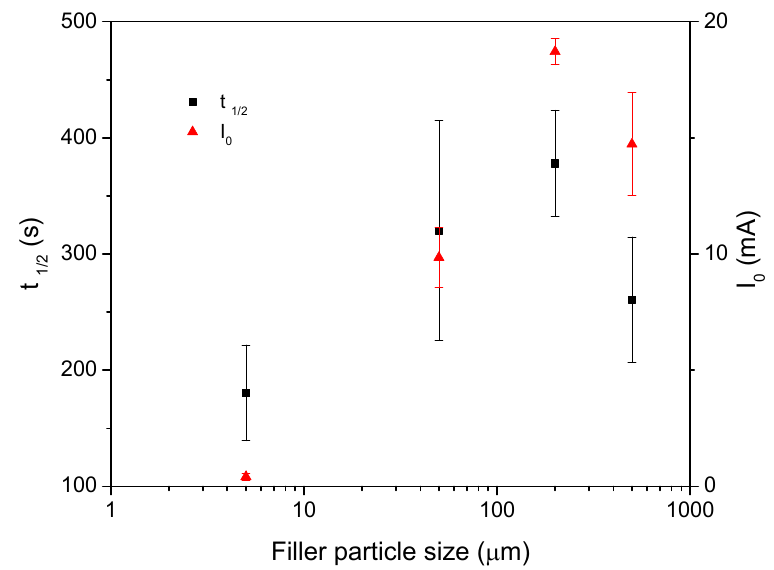
Figure 5. Dependence of the parameter t 1 / 2 and the initial current value I 0 on the filler particle size (axis in logarithmic scale) with data points corresponding to mean values and their standard deviation values (error bars) from three experiments.